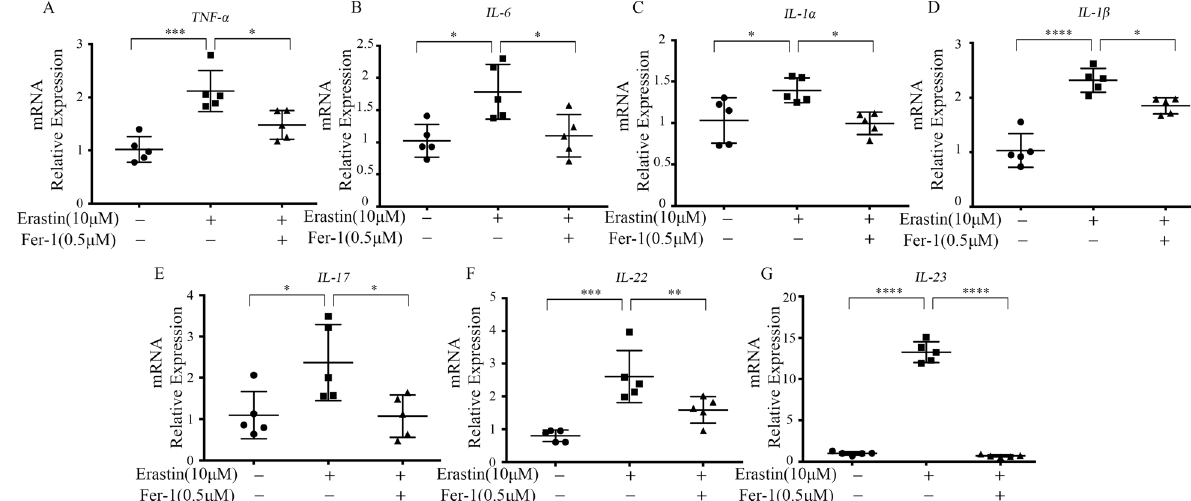
Fig. 4 In fl ammation levels changes in erastin-treated keratinocytes. A – G Keratinocytes were stimulated with 10 μ M erastin for 24 h, with or without 0.5 μ M Fer-1 treatment ( n = 5). The mRNA expression of in fl ammatory cytokines including TNF- α , IL-6 , IL-1 α , IL-1 β , IL-6 , IL-17 , IL-22 , and IL-23 was examined. Actin was used as the loading control. Values were presented as the mean ± standard error ( n = 5). * P < 0.05, ** P < 0.01, *** P < 0.001. Independent experiments were repeated three times. Fer-1 ferrostatin-1.